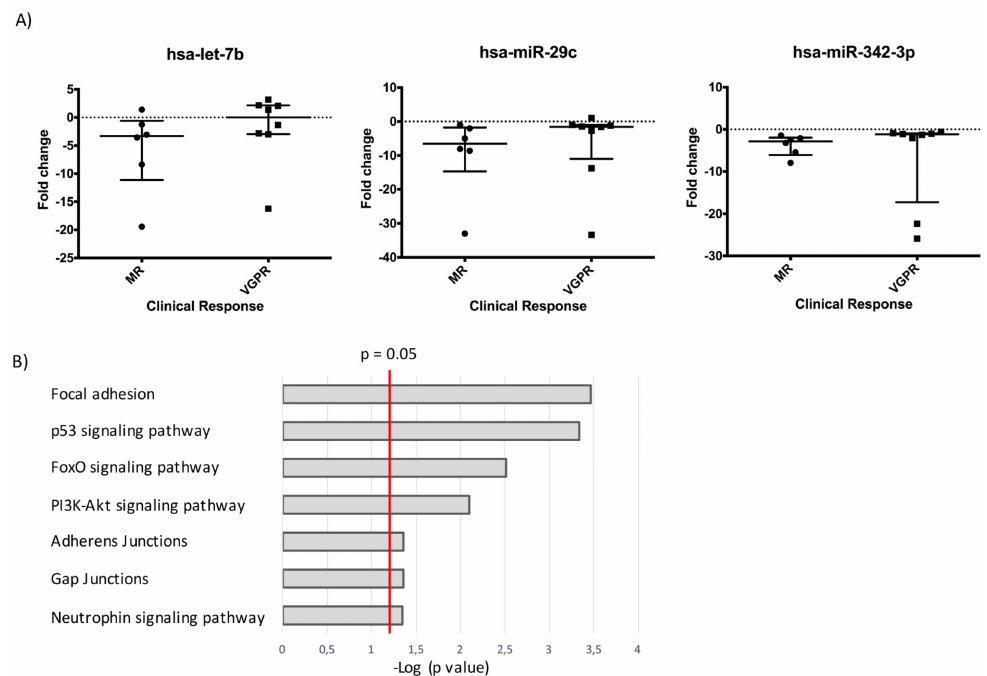
Figure 3. A three exo-miRNAs signature di ff erentiates MR and VGPR patients. ( A ) Dot plot graphs show the FC values after induction chemotherapy of each exo-miRNAs for each MR (minor responders) and VGPR (very good partial responders) patient. The median and the interquantile range values are reported. In VGPR patients let-7b, miR-342-3p, and miR-29c are not modulated, while in MR patients they are downregulated. ( B ) Result of the pathway analysis performed with miRNet showing the enrichment of several pathways related to cancer development and chemoresistance. The bar chart reports the most significantly enriched pathways, listed by decreasing p values, that are relevant for tumor progression and